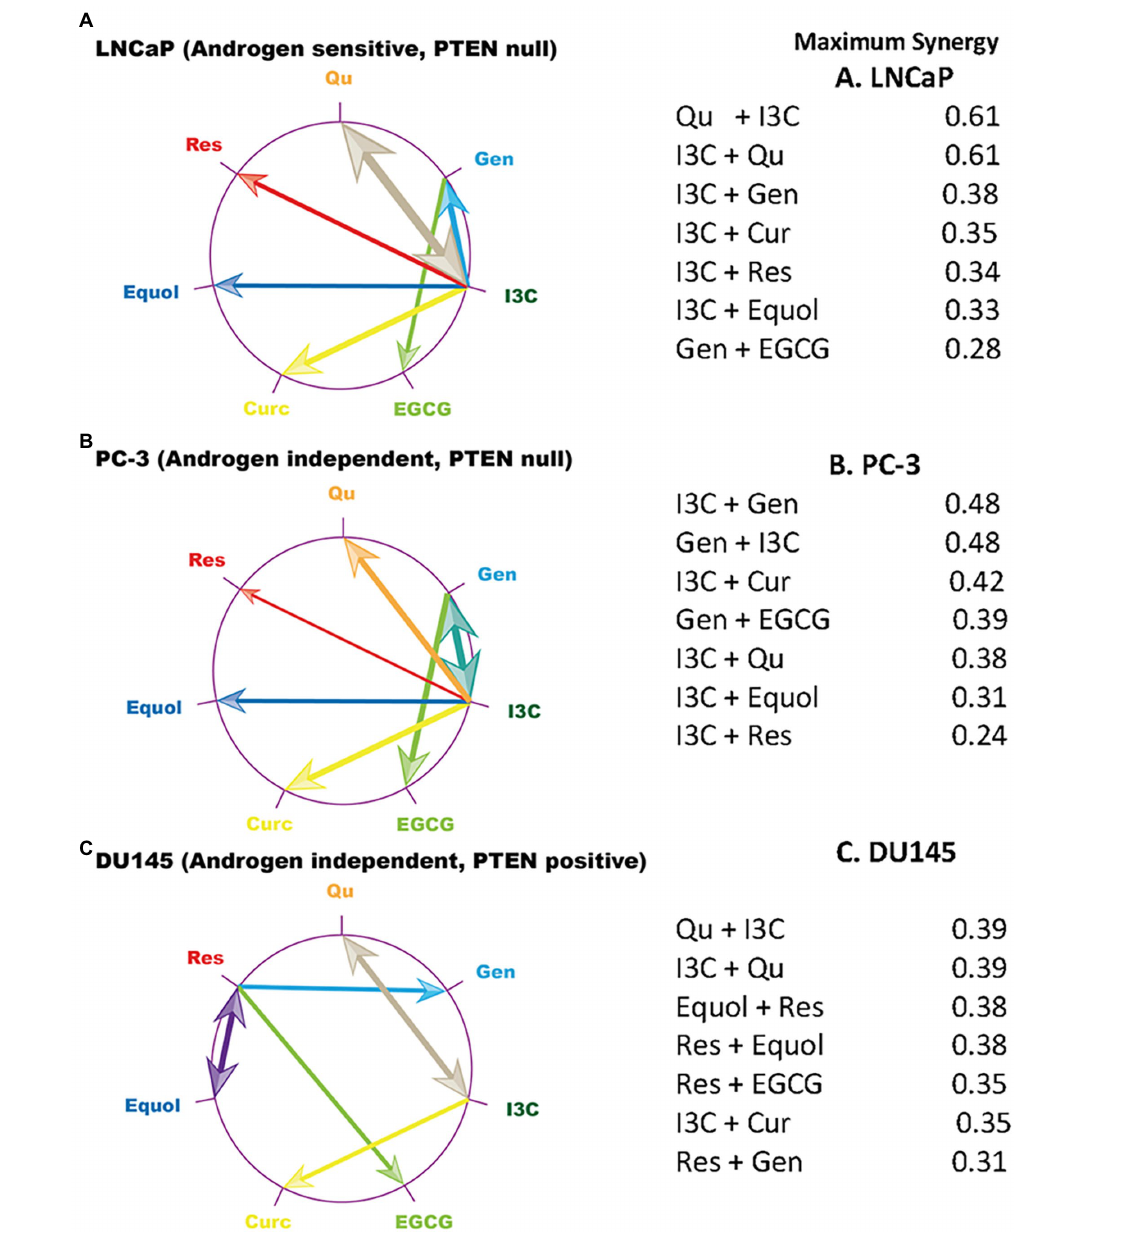
FIGURE 1 Maximum synergy signatures of prostate cancer cell line models. The compound which showed the maximum synergy at any concentration ratio in combination with each phytochemical on the edge of the circle is linked to that phytochemical by an arrow. Arrow width is scaled to represent the size of the maximum synergistic response which is tabulated. Data plotted were generated from the Bliss model (Supplementary Figures S3A–C). Qu, quercetin; Gen, genistein; I3C, indole 3 carbinol; EGCG, epigallocatechin gallate; Curc, curcumin; Res, resveratrol. ( A ) LNCaP cells, ( B ) PC-3 cells, ( C ) DU145